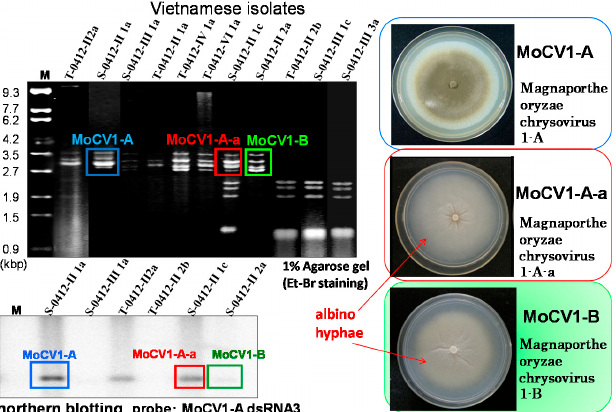
Figure 1. Distribution map of rice blast fungus infected with mycoviruses. Mycoviruses with dsRNA genomes were found in 11 M. oryzae isolates from three provinces in the Mekong Delta region of Vietnam. The plant diagrams show the sites where disease lesions were sampled. The agarose gel shows viral dsRNA segments present in the infected M. oryzae isolates. Two mycoviruses were identified: MoCV1 had five dsRNA genomic segments of 2.6 kbp to 3.6 kbp, and a partitivirus had three segments of 1.8 kbp to 2.4 kbp. The M. oryzae isolates, S-0412-II 1a, S-0412-II 1c, and S-0412-II 2a, were infected with the MoCV1 strains, MOCV1-A, MOCV1-A-a, and MOCV1-B, respectively. Isolate S-0412-II 1c was also infected with the partitivirus.